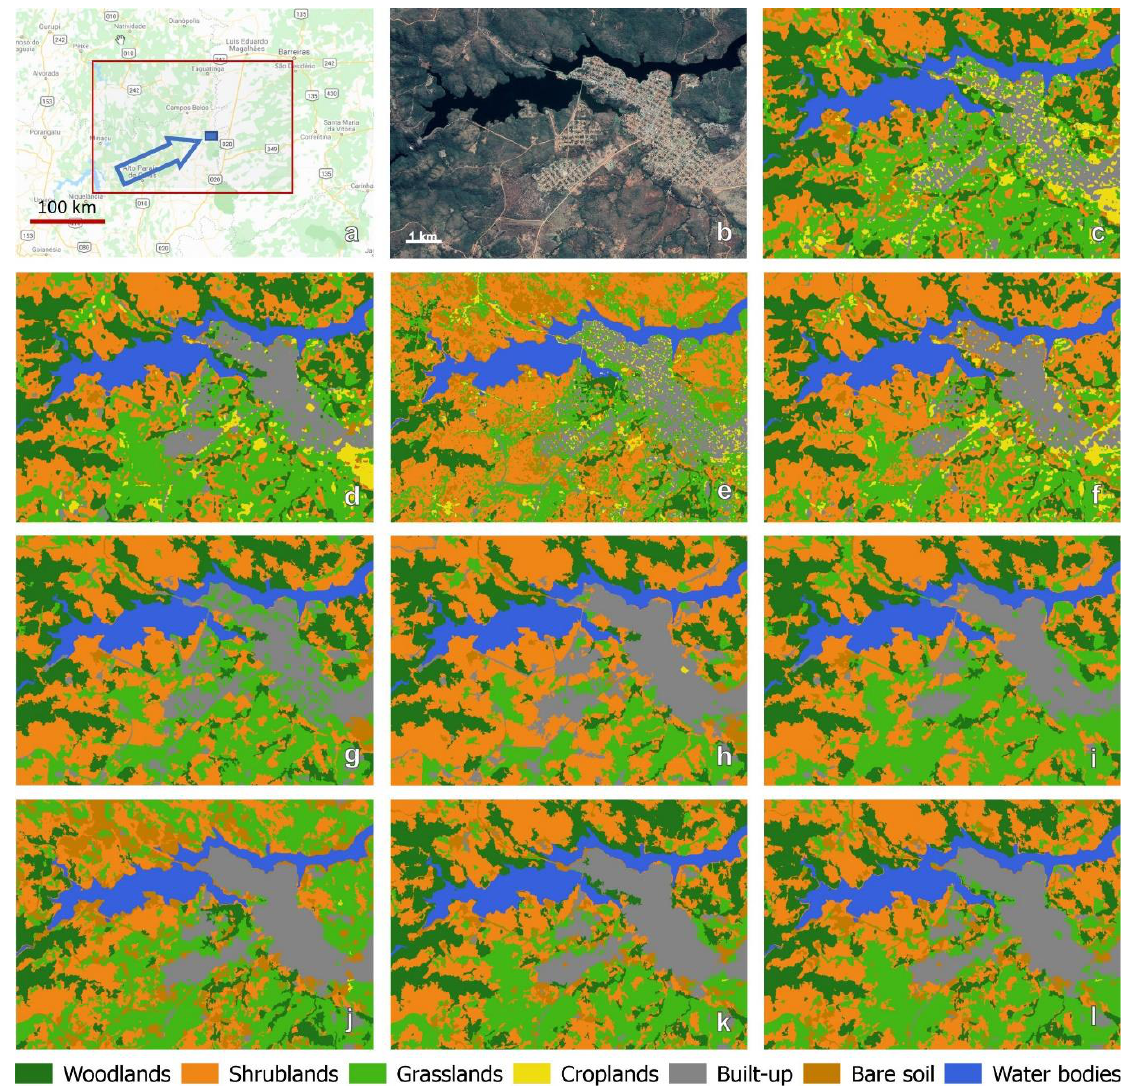
Figure 3. Comparison of LULC classification approaches in a representative region of the study area. Location of the area (blue arrow and rectangle) within the study area (red rectangle) ( a ), Google aerial view ( b ), 1_PB_S2 ( c ), 2_PB_S2S1 ( d ), 3_PB_PL ( e ), 4_PB_S2S1PL ( f ), 5_OB_S2 ( g ), 6_OB_S2S1 ( h ), 7_OB_S2S1T ( i ), 8_OB_PL ( j ), 9_OB_S2S1PL ( k ), 10_OB_PLS2S1 ( l ). Codes are reported in Table 2.